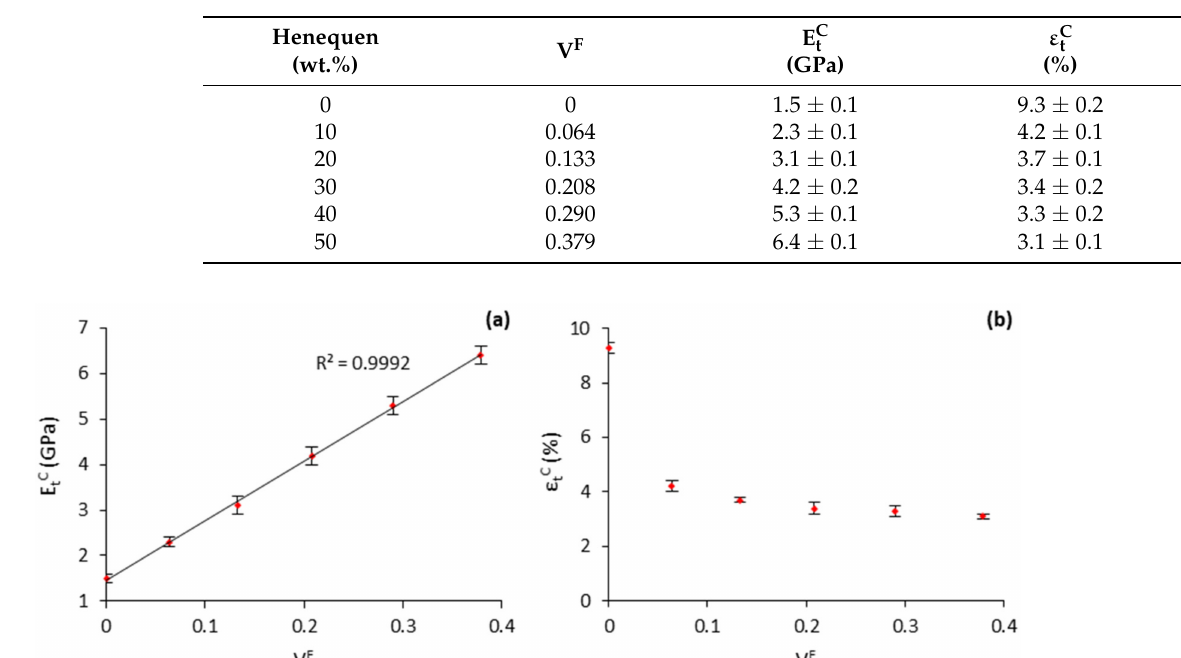
Figure 4. Evolution of the ( a ) Young’s modulus (E C t ); ( b ) elongation at maximum stress ( ε C fraction (V F